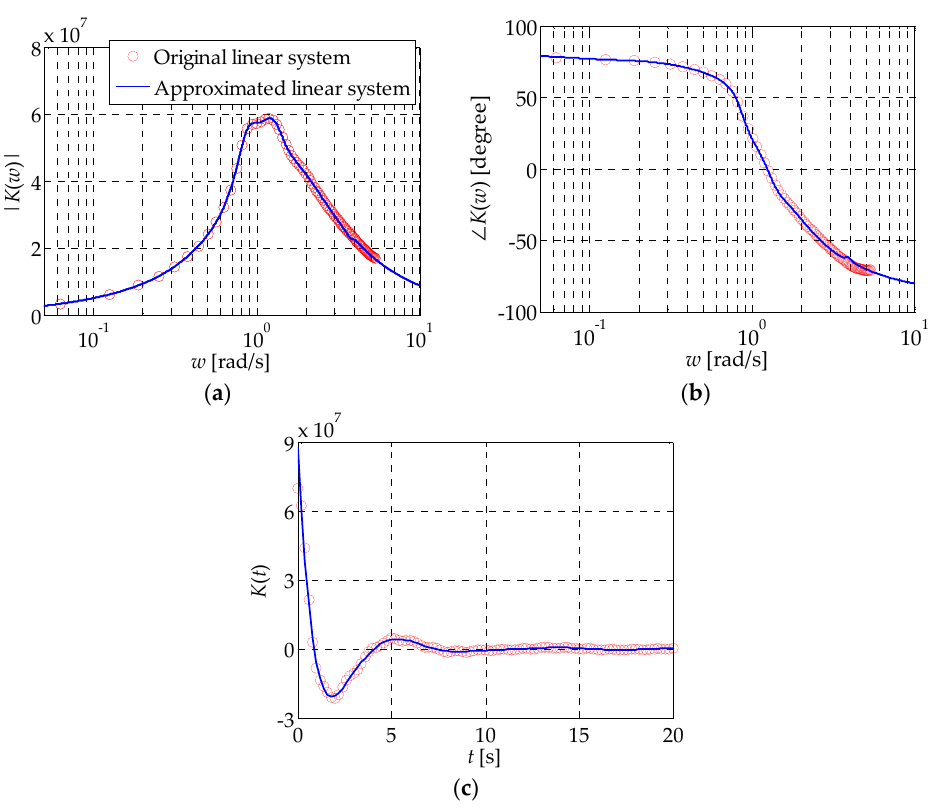
Figure 2. Comparison of the frequency-response function (FRF) and impulse-response function (IRF) between the original and approximated linear system: ( a ) magnitude of K ( w ); ( b ) phase angle of K ( w ); ( c ) K ( t ).